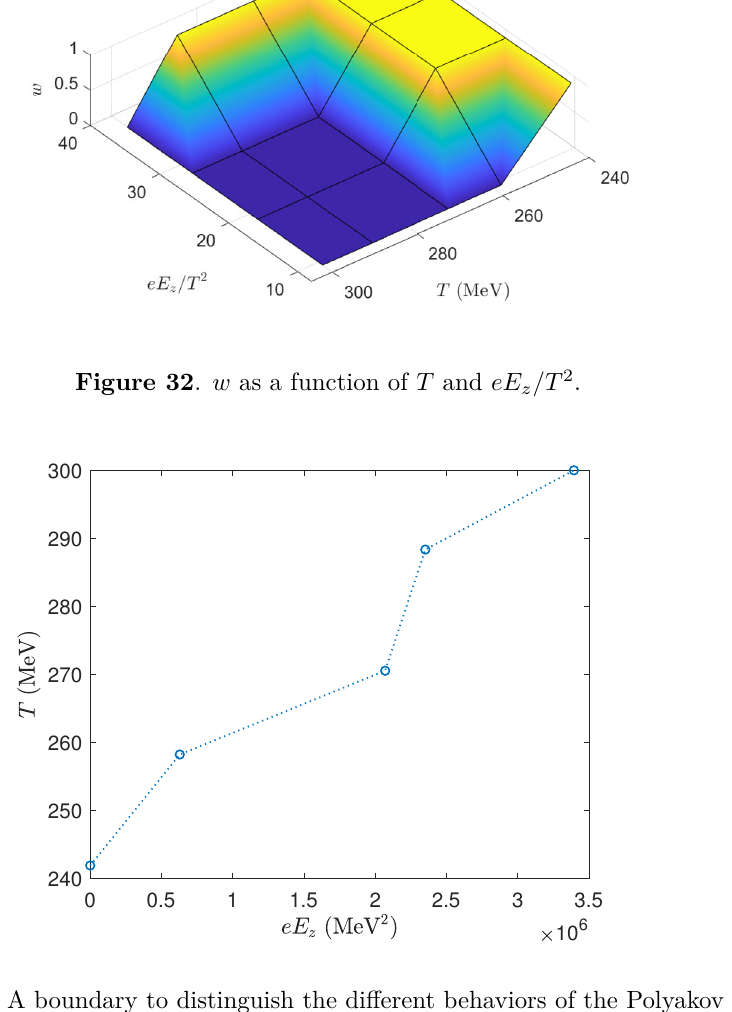
Figure 33 . A boundary to distinguish the different behaviors of the Polyakov